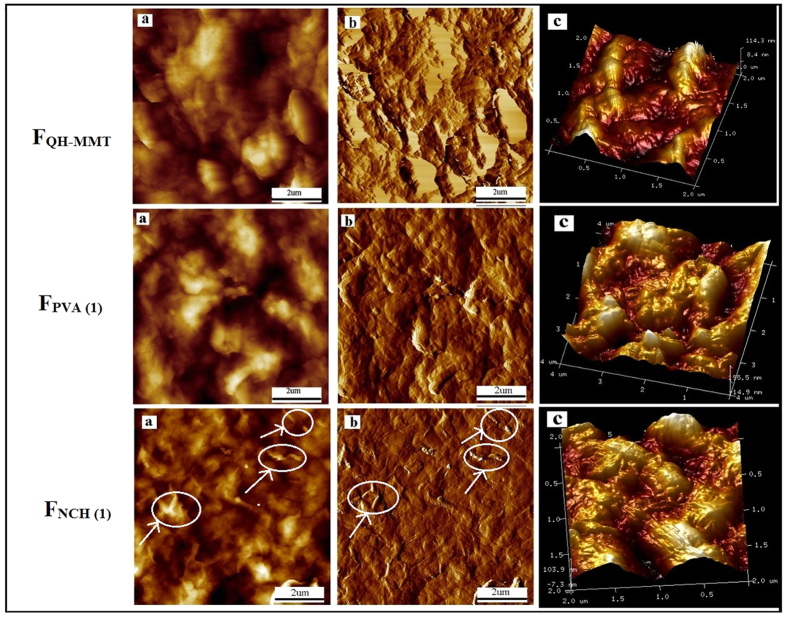
AFM height images, phase topography and 3D topography of the FQH-MMT, FPVA (1), and FNCH (1) films: FQH-MMT (a–c); FPVA(1) (a–c); FNCH(1) (a–c).